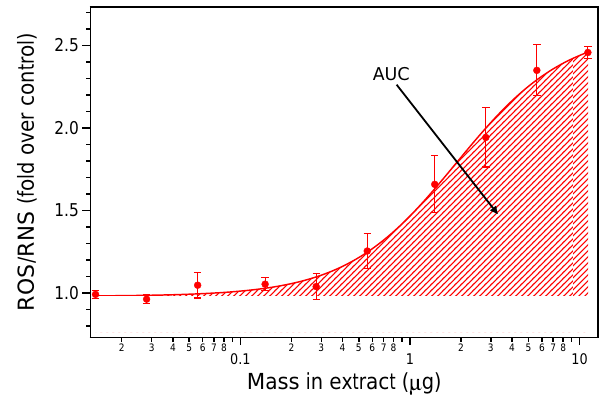
Figure 1. Representative dose-response curve of ROS/RNS pro- duced as a result of filter exposure (naphthalane SOA formed un- der dry, RO 2 + NO dominant conditions). ROS/RNS is expressed as a fold increase over control cells, defined as probe-treated cells incubated with stimulant-free media. Dose is expressed as mass in extract (µg). Data shown are means ± standard error of triplicate exposure experiments. The Hill equation was used to fit the dose- response curve and the area under the dose-response curve (AUC) is shown.